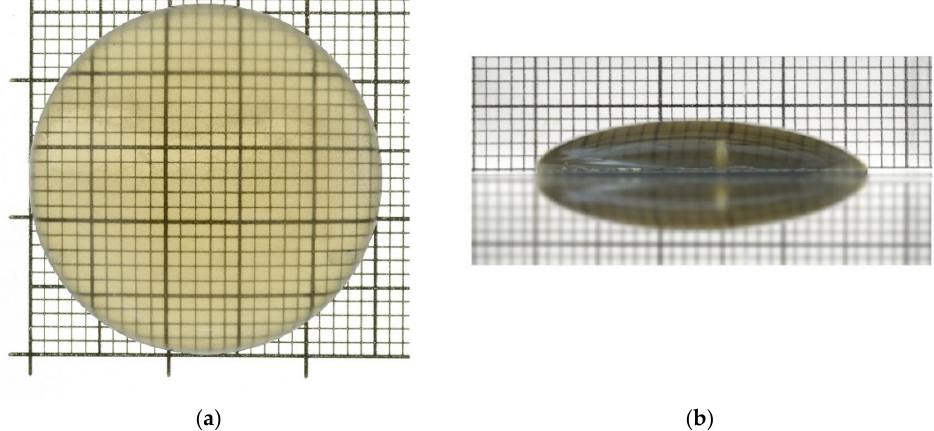
Figure 1. Selected and specially prepared Am-GaN seed with a lenticular shape: ( a ) top view of the (0001(cid:3364)) plane; ( b ) side view. The thickness of the seed at its center was 4.1 mm; radii of the surface curvature varied between 21 and 25 mm; grid line 1 mm.